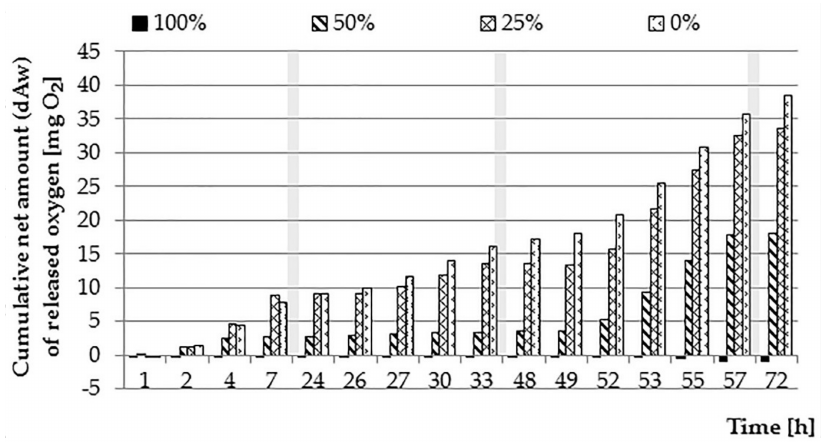
Figure 5. The net amount of oxygen dA w introduced into wastewater solutions (0, 25, 50, and 100%) by E. densa (periods of nighttime—without measurements—marked as grey zones).